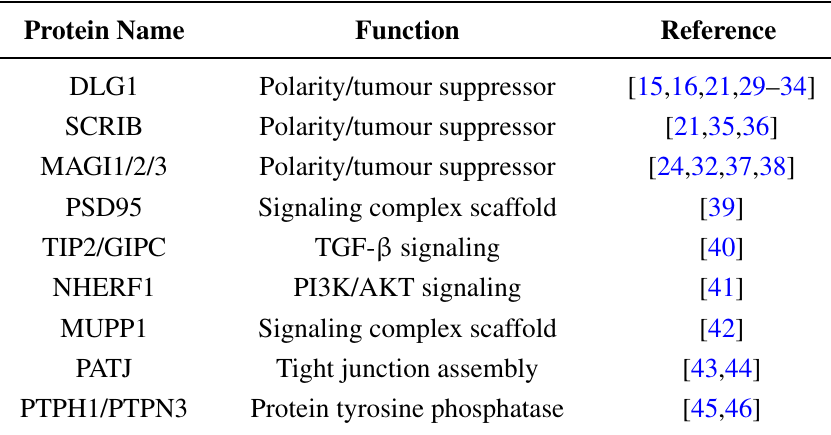
Table 1. Known PDZ Domain containing targets of E6.